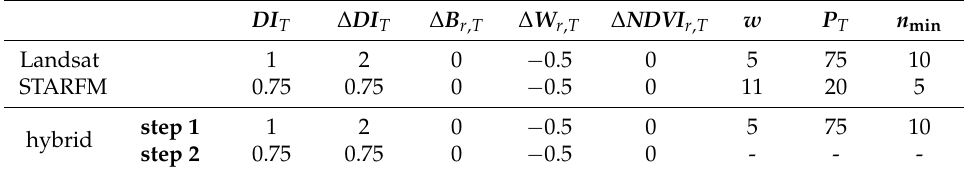
Table 1. Disturbance detection parameterization for the standalone Landsat and STARFM detections, as well as the hybrid detection, which follows the parameterization of the standalone detections. DI T ∆ DI T ∆ B r , T ∆ W r , T ∆ NDVI r , T w P